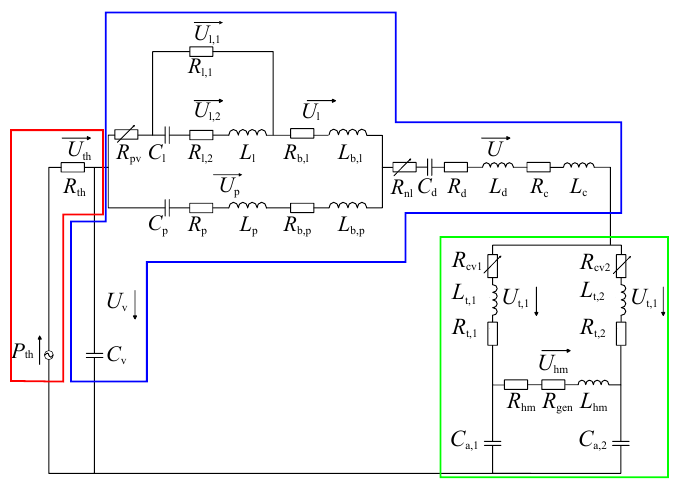
Figure 3. Circuit diagram of the Up-THERM engine. The colors represent the same domains (thermal, fluid, and load) of the engine as shown in Figure